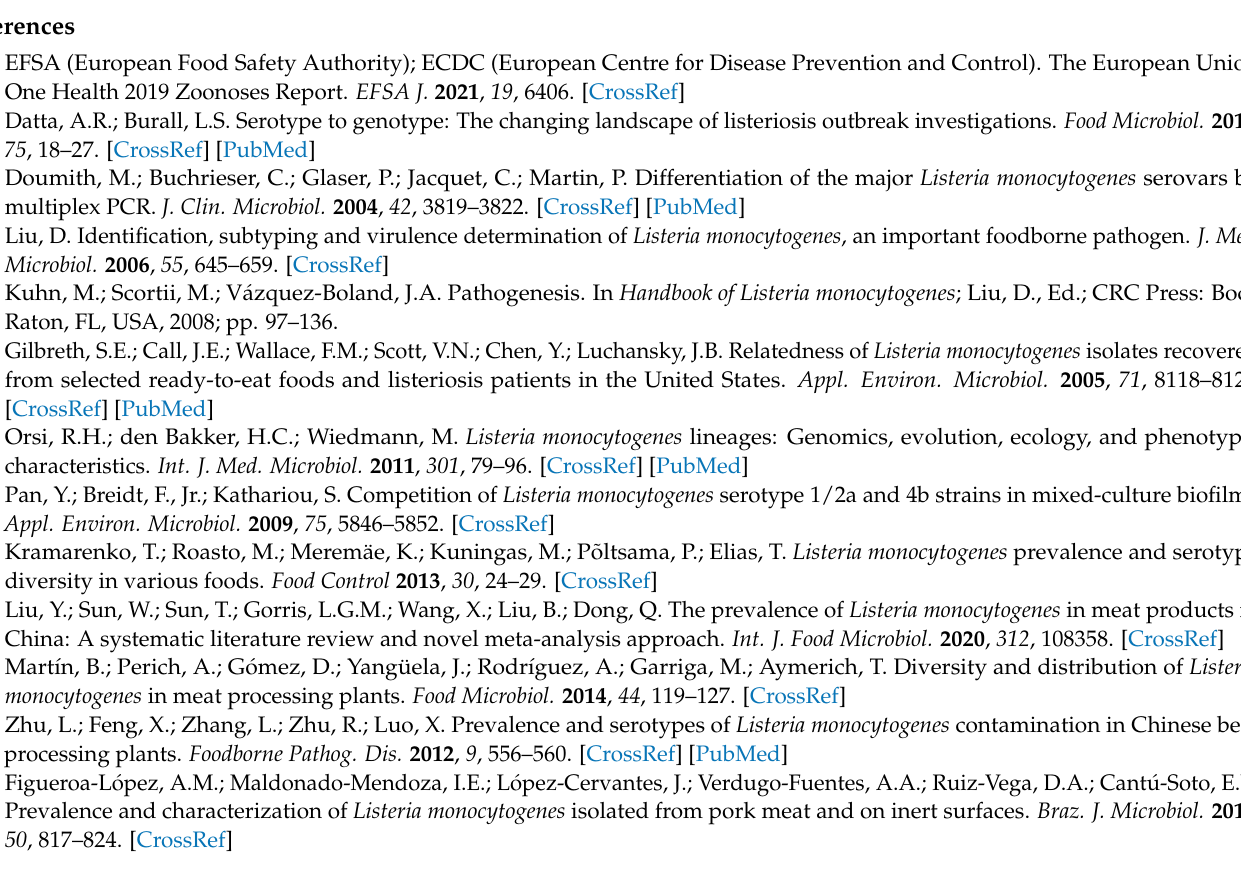
Figure A1. Diagrammatic illustration of the experimental design. The study involved the microbiological analysis of sample replicates ( n = 3) and the plating in triplicate of three serial decimal dilutions in one independent trial of the experiment.